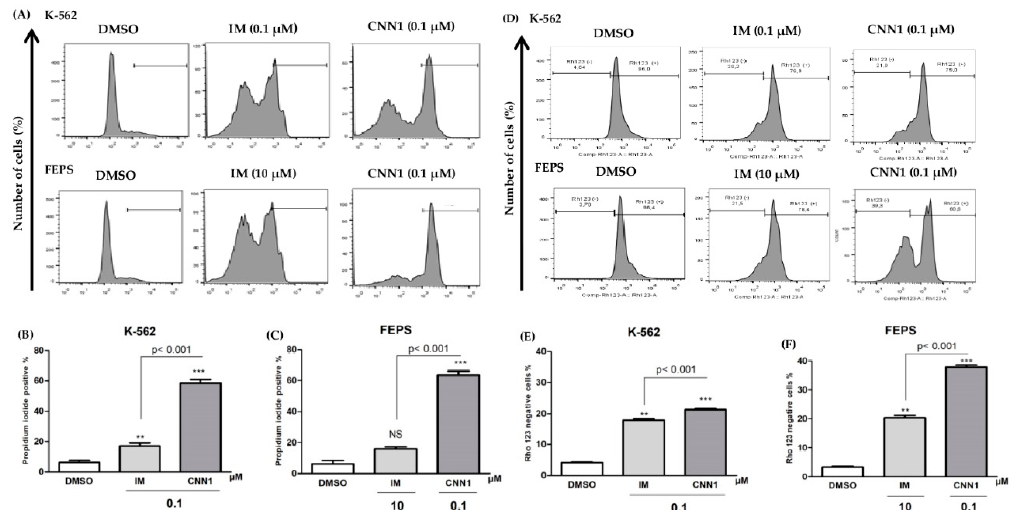
Figure 1. CNN1 caused a significant rupture in the membrane integrity and induced mitochon- drial depolarization on K-562 and FEPS cells, after 24 h treatment (0.1 µ M): ( A ) Detection of PI of the negative control (DMSO) and treated groups; ( B ) CNN1 significantly affected the membrane integrity in K-562 cells; ( C ) CNN1 can also induce disruption in membrane integrity in FEPS cells; ( D ) identification of Rhodamine 123 in negative control (DMSO) and treated groups; ( E ) Rhodamine 123 negative cells after treatment with CNN1 in K-562 cells; ( F ) CNN1 induces mitochondrial mem- brane depolarization in FEPS after CNN1 exposure. Data from membrane integrity are presented as mean ± SD of three independent experiments. Treated samples were compared to DMSO and statis- tically analyzed by ANOVA followed by Bonferroni’s post-test. Significant differences: ** p < 0.01, *** p < 0.001. NS = non-significant.